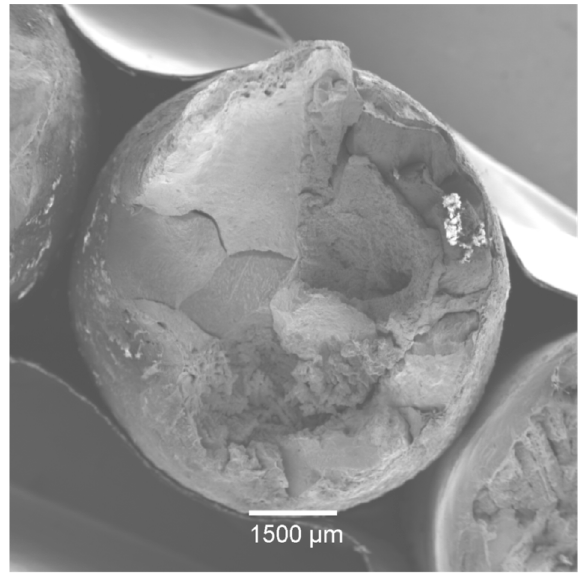
Figure 4. “Rock candy” fracture in a TRIP steel containing 1.05%Al [3].